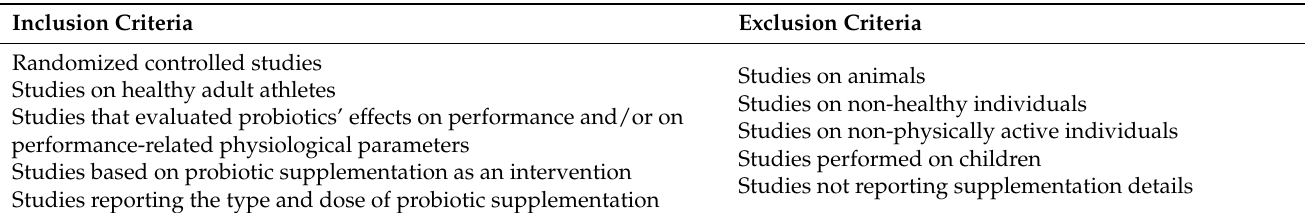
Table 1. Inclusion and exclusion criteria used in the article